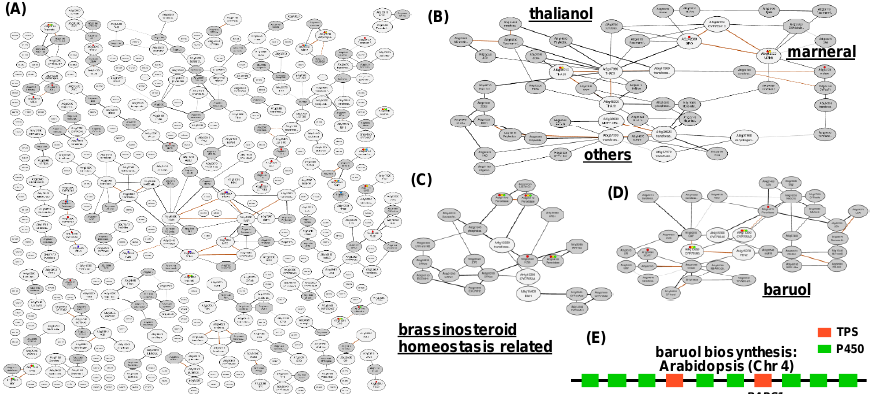
Figure 2. Co-expression analysis of neighboring genes in Arabidopsis genome. ( A ) a global overview of the co-expression of clustered genes in Arabidopsis, ( B ) a co-expression network of terpenoid metabolic gene clusters, ( C ) a co-expression network of baruol synthase, ( D ) a co-expression network of putative brassinosteroids homeostasis related genes, ( E ) putative gene cluster of baruol biosynthesis. Abbreviations: terpene synthases; P450, CYP.